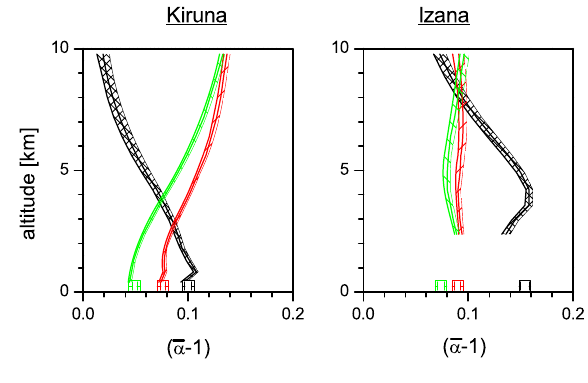
Fig. 6. Time series of the TNA (Tropical Northern Atlantic) and the NAO (North Atlantic Oscillation) index.